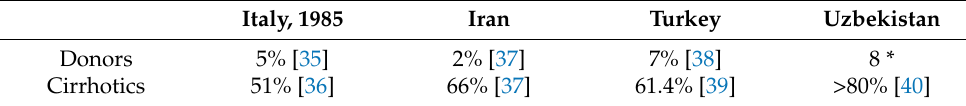
Table 1. Different prevalence of anti-HD in HBsAg blood donors and HBsAg